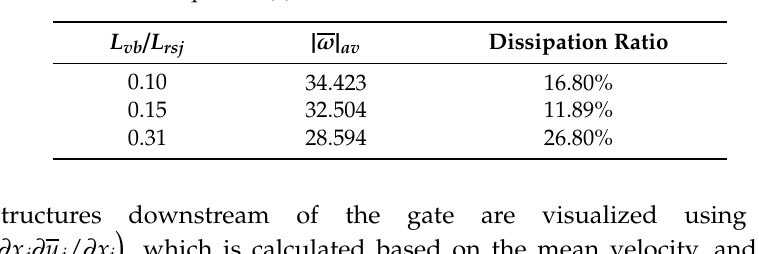
Table 5. Comparison of vortex damping performance of horizontal porous ba ffl e for di ff erent lengths. Here, L rsj is calculated from Equation